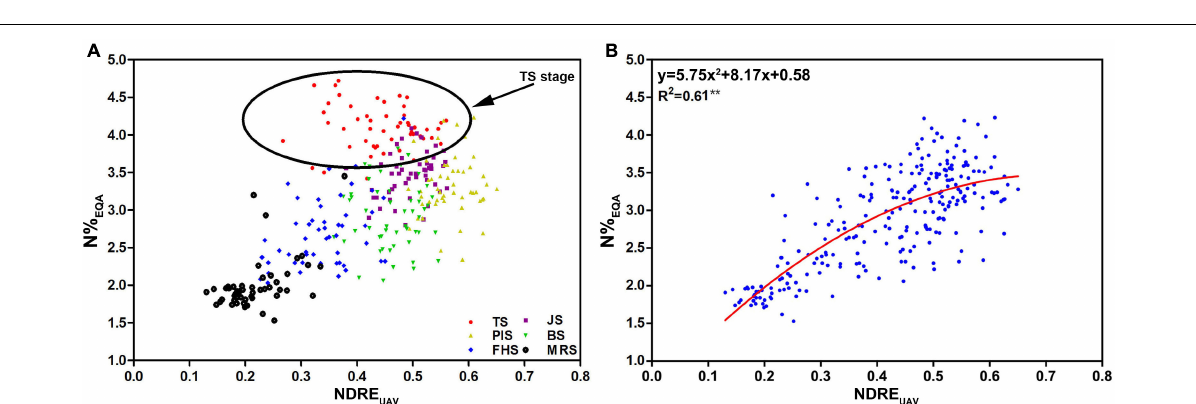
FIGURE 5 | Shown are the RGB image and NDRE UAV that were obtained by the Unmanned Aerial Vehicle Remote Sensing Platform (UAV-RSP) in the six key developmental stages. (A) RGB image: (a) TS; (b) JS; (c) PIS; (d) BS; (e) FHS; (f) MRS. (B) NDRE UAV illustration: (a) TS; (b) JS; (c) PIS; (d) BS; (e) FHS; (f) MRS. NDRE UAV value varied between 0: cold blue color and 1: warm red color; warmer color indicates higher N accumulations than colder color in rice plants.